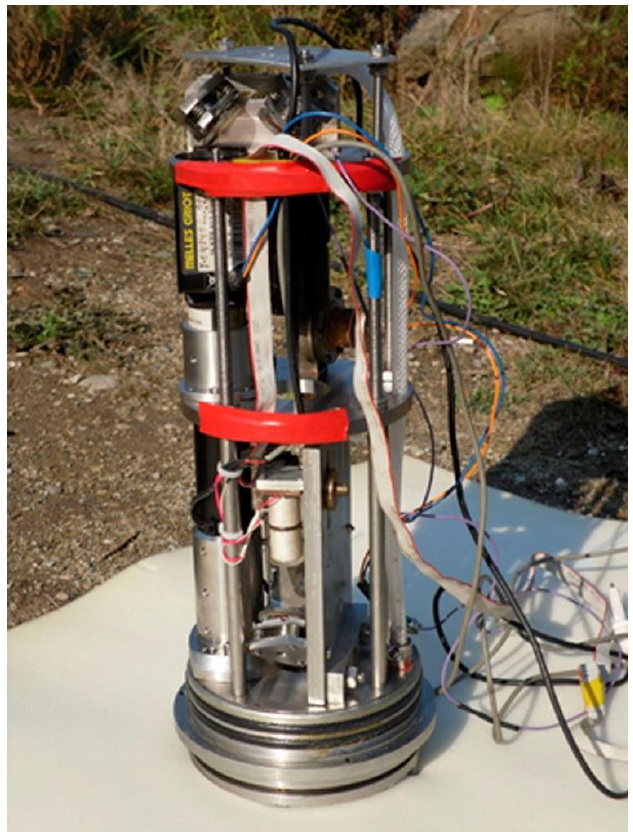
Figure 1. Internal view of the supersensitive detector of hydrosphere pressure variations.